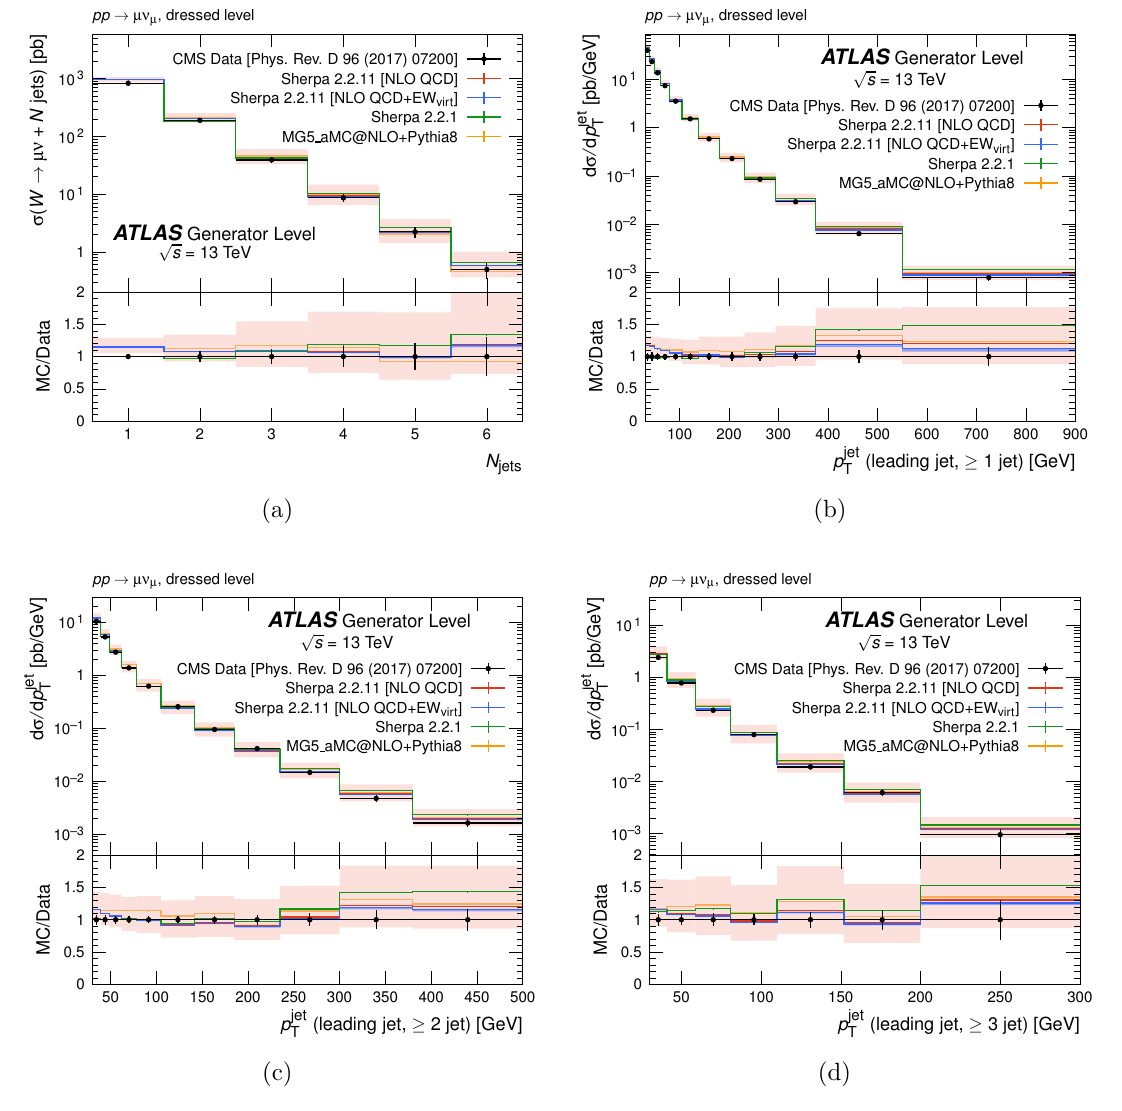
Figure 5 . Comparisons between generator-level W → µν predictions and measured data points. The red uncertainty band includes the envelope of the 7-point scale variations around the Sherpa 2 . 2 . 11 NLO QCD prediction. The blue uncertainty band is the envelope of multiplic- ative and exponentiated NLO EW schemes around the additive NLO EW prediction. Data virt virt √ points are taken from CMS measurements at s = 13 TeV